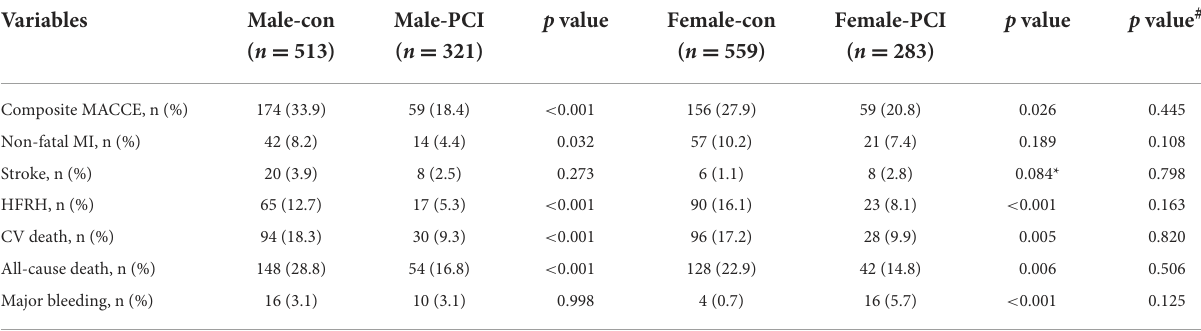
TABLE 5 The comparison of MACCE in PCI and conservative management group by different sexes.